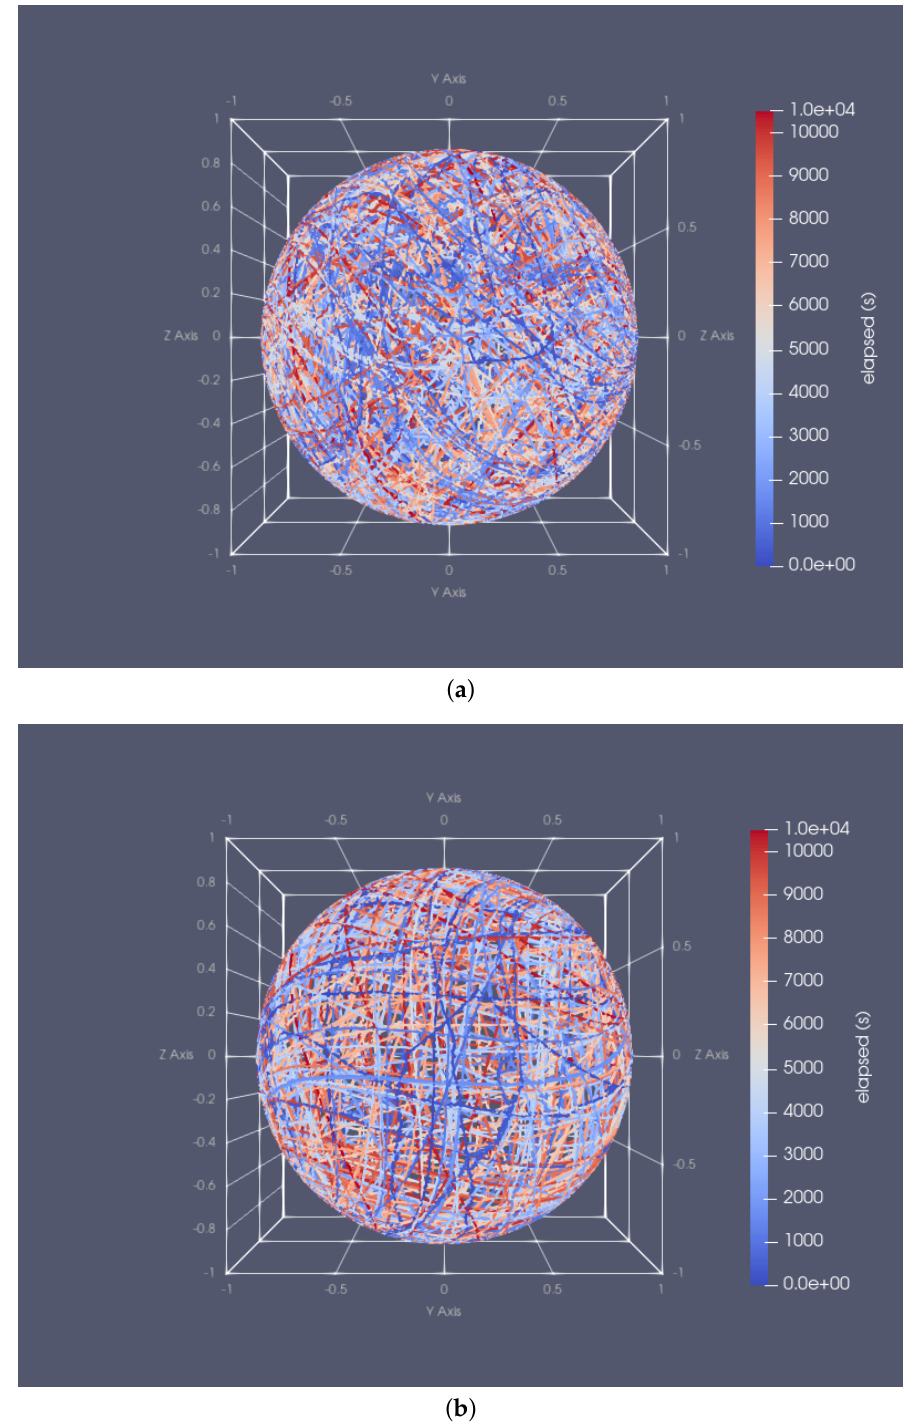
Figure A4. Motion trajectory of the gravity vector tip in random mode ( ω φ and ω ϕ are randomly selected within range between 0.0524 [rads/s] and 0.733 [rads/s] and periods of rotation of both frames are randomly selected from 1 to 10 periods) ( a ) at a distance of 0 cm from the center and ( b ) at a distance of 3.5